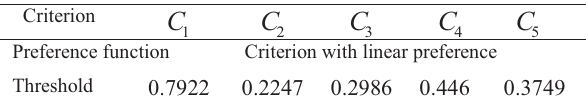
Table 13. The preference function and threshold of each criterion